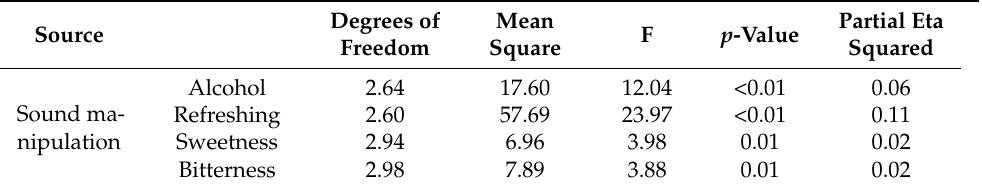
Table 3. Summary of the results of the univariate tests (Greenhouse–Geisser-corrected) of Experiment 1 at the within-participants level (sound manipulation condition) on each sensory